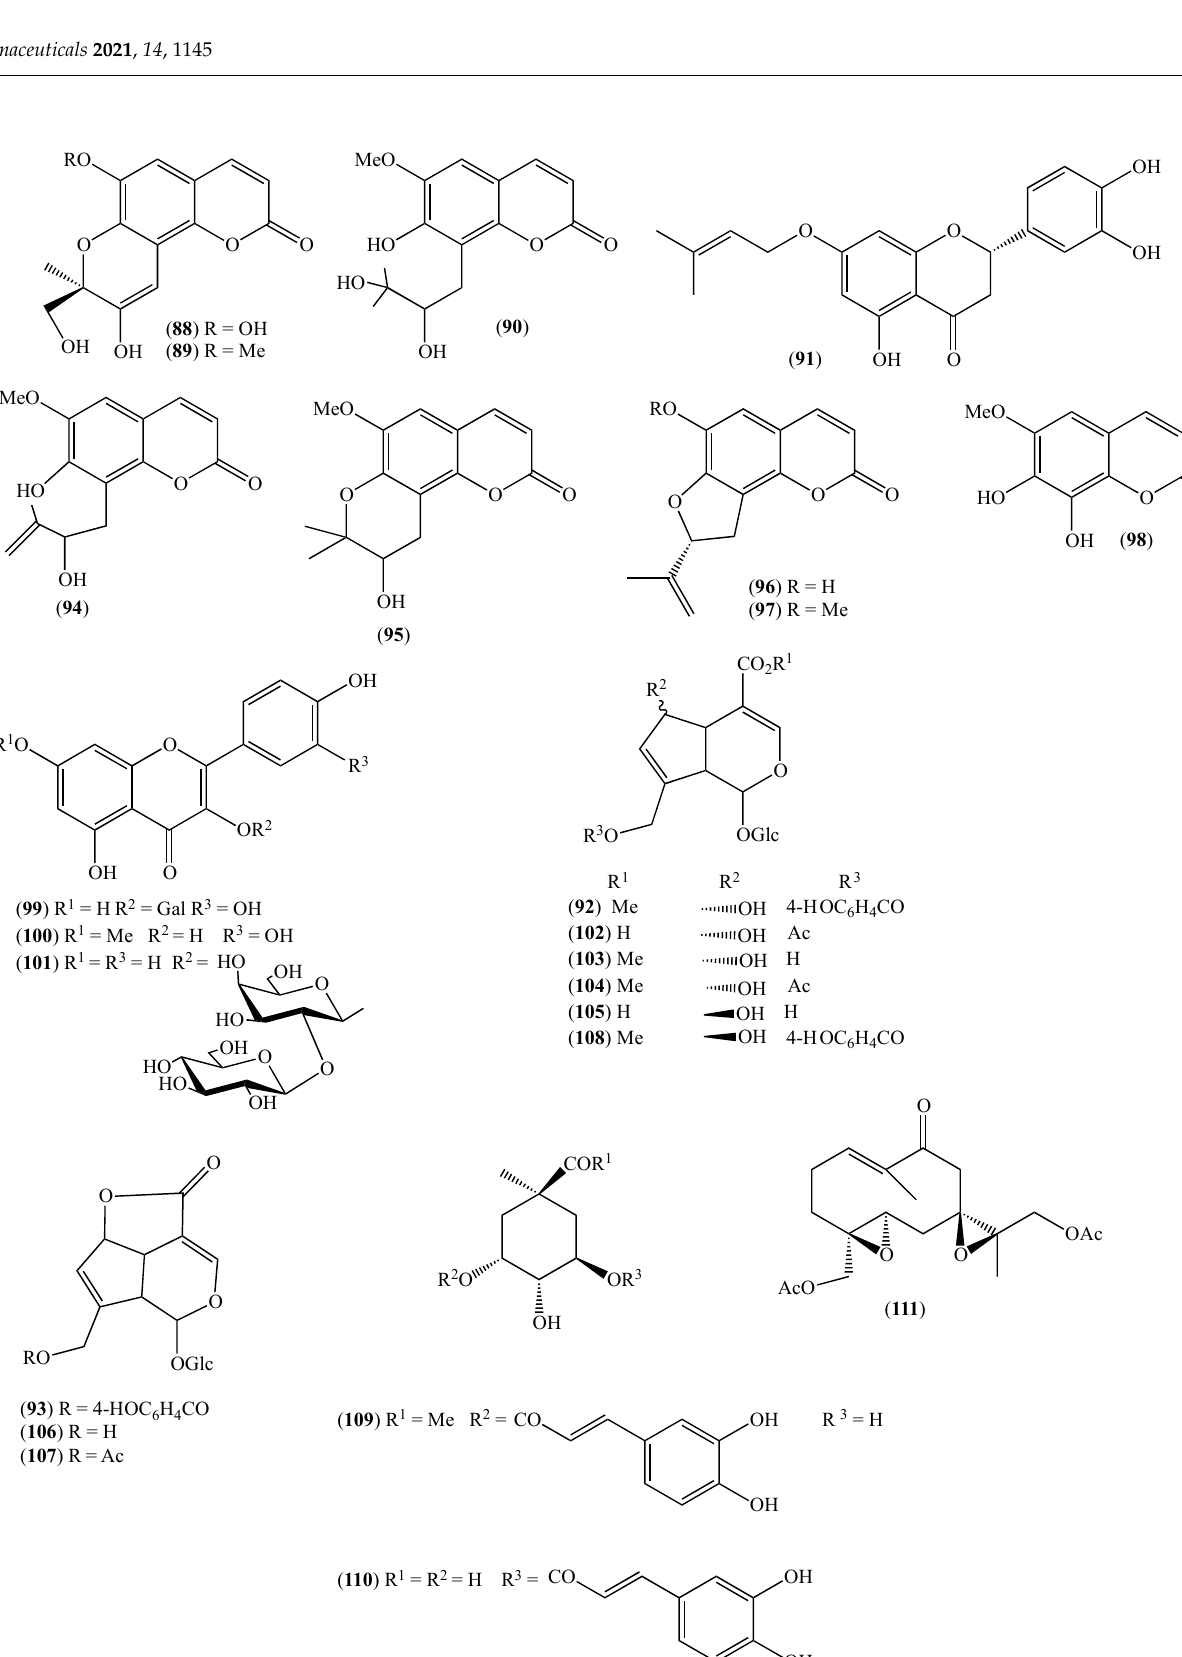
Figure 13. Structures of compounds 88 – 110 from Arcytophyllum thymifolium and 111 from Siparuna echinata .